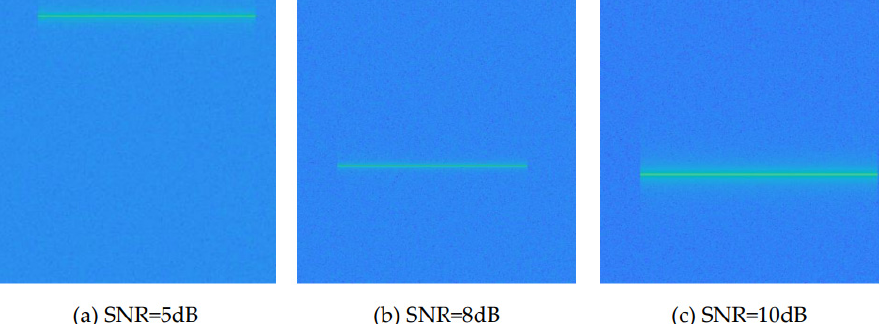
Figure 7. Time frequency diagram of single frequency interference with different SNR in Gaussian channel. ( a ) SNR = 5dB, ( b ) SNR = 8dB, ( c ) SNR = 10dB.